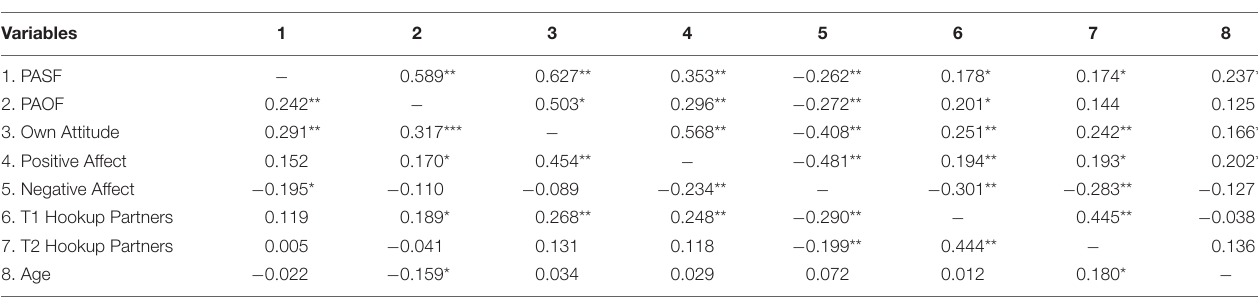
TABLE 2 | Zero-order correlations by sex ( N = 314).